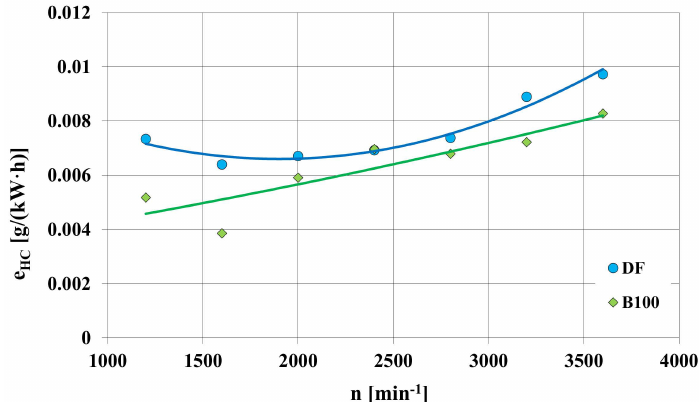
Figure 6. External speed characteristics of the specific brake emission of hydrocarbons e HC in the rotation speed domain-n for the engine powered with fuels DF diesel or B100.